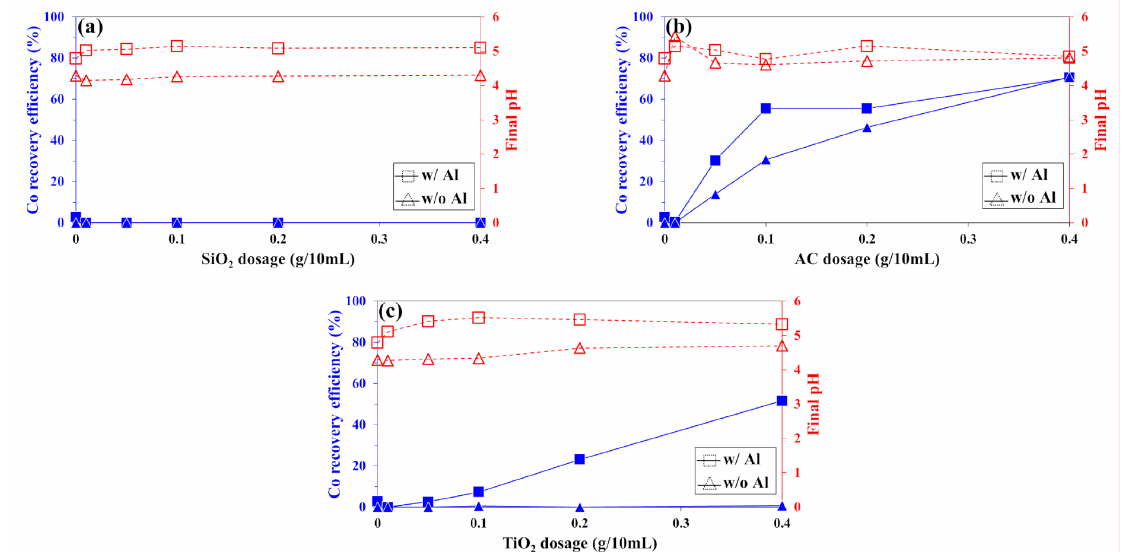
Figure 2. The effects of ( a ) SiO 2 , ( b ) AC, and ( c ) TiO 2 dosages on the recovery efficiency of Co 2+ and final pH in sulfate solutions at initial pH 4.0 for 24 h.